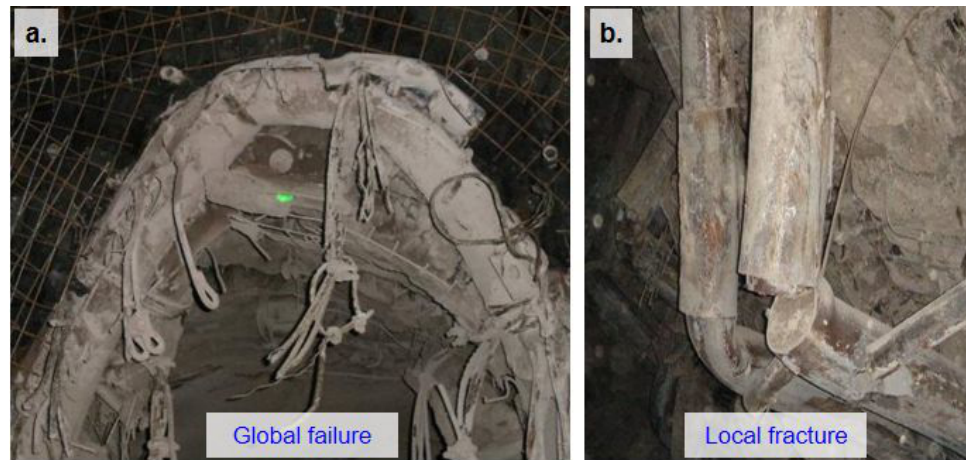
Figure 1: Failure cases of the mine roadways supported with CFST arches.